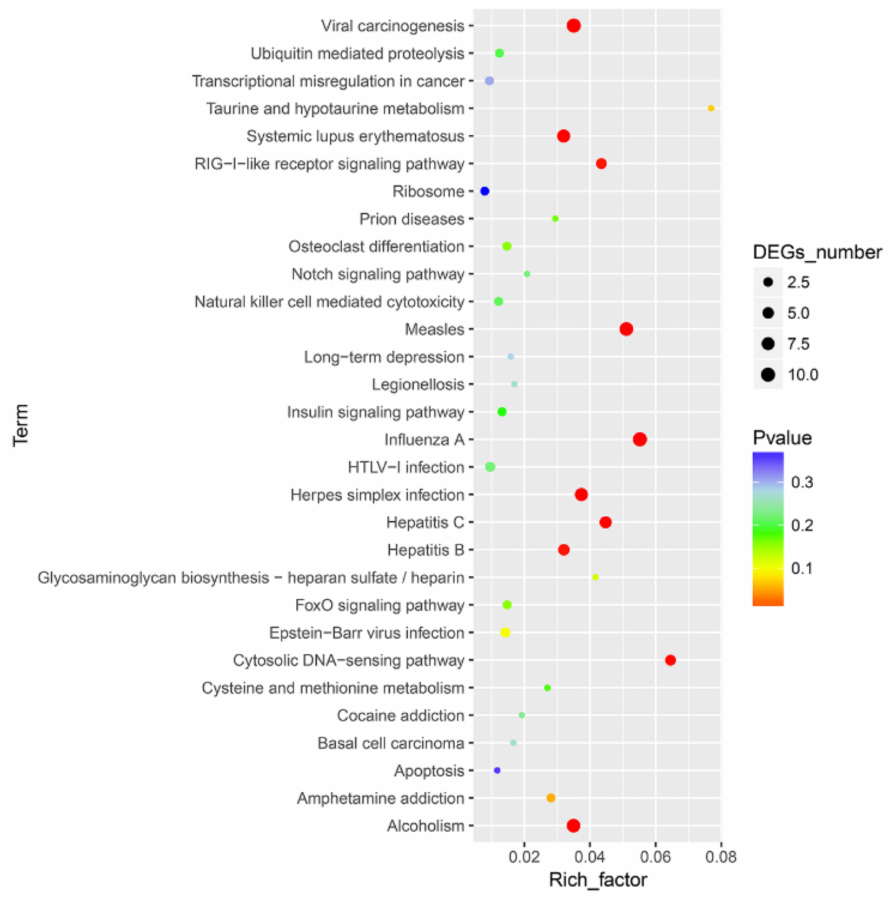
Figure 4. Top 30 pathways enriched in Kyoto Encyclopedia of Genes and Genomes (KEGG) database for the DEGs between CpHV-1-infected and mock-infected MDBK cells. The abscissa represents the enrichment factor, and the ordinate represents the classification of the KEGG metabolic pathway. Circles indicate numbers of enriched genes, and colors depict the p -value. The size of each circle represents the number of significant DEGs enriched in the corresponding pathway. The enrichment factor was calculated using the number of enriched DEGs divided by the total number of background genes in the corresponding pathway. The chromatogram from blue to red represents the uncorrected p -value. A pathway with a p -value < 0.05 is considered to be significantly enriched. A detailed representation of the data is provided in Table